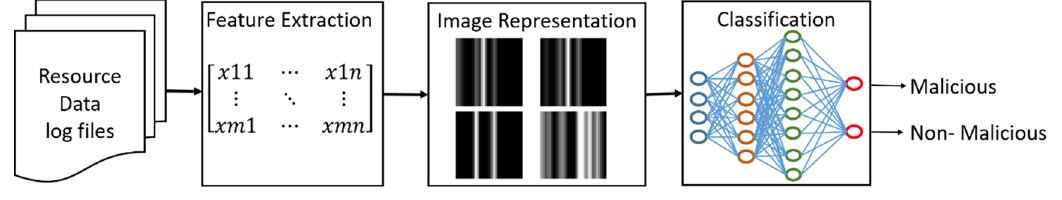
Figure 1. Overall process flow.